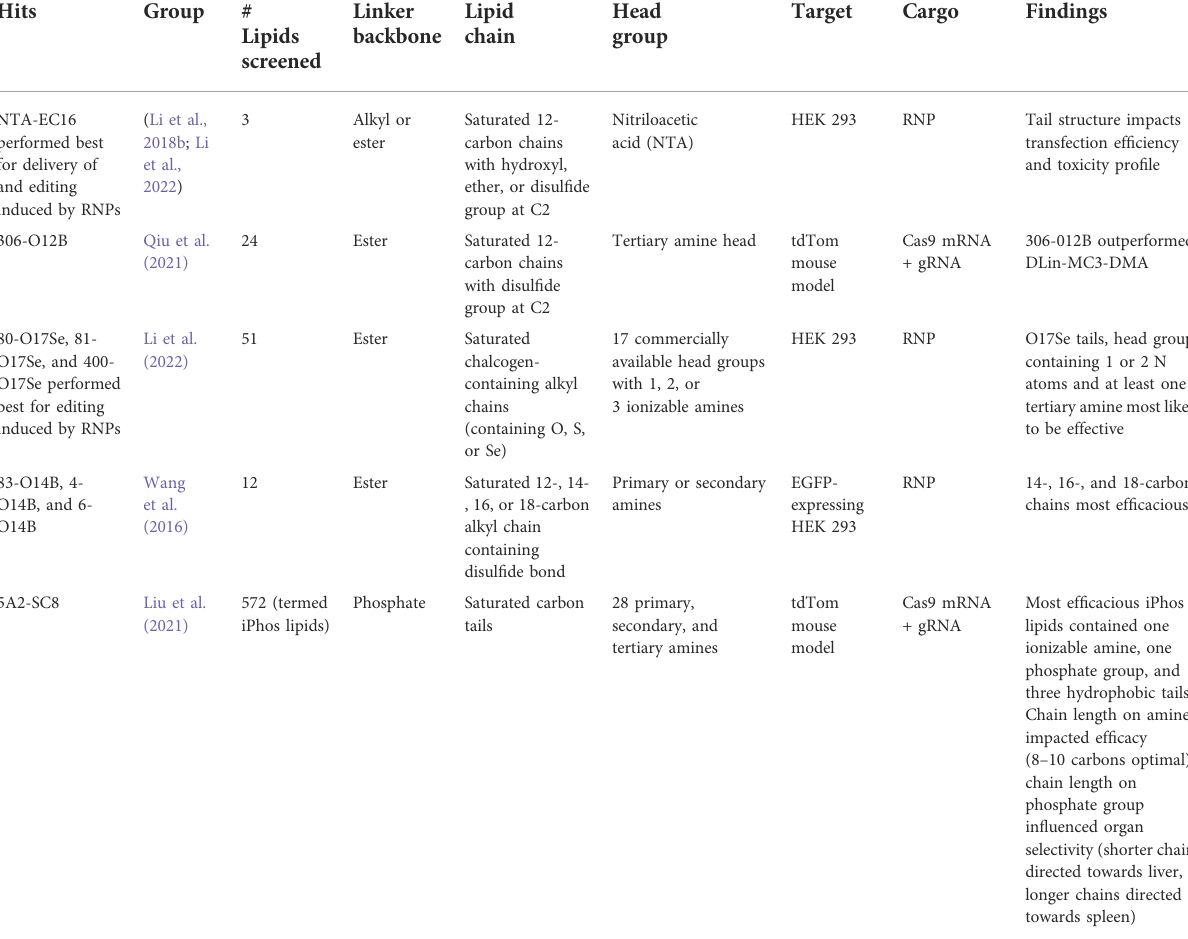
TABLE 1 Summary of novel lipids and lipidoids systematically designed and screened for their capabilities to deliver gene editing cargoes to